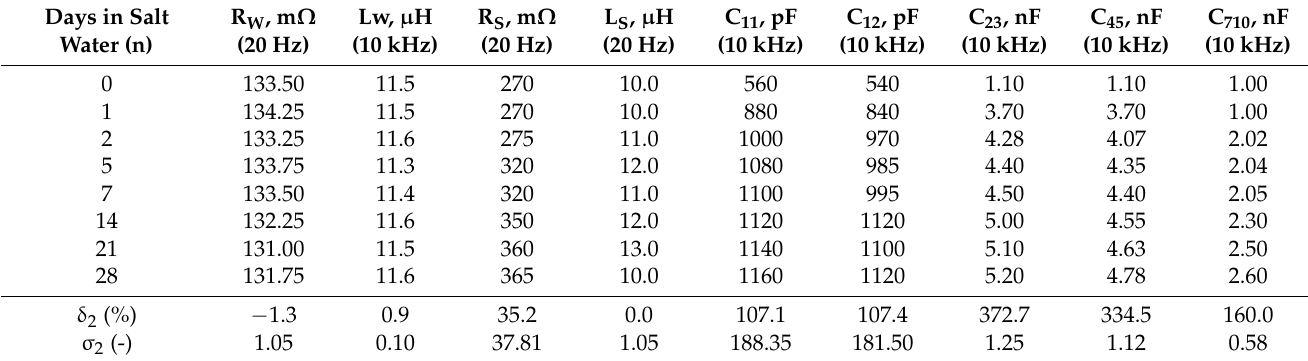
Table 3. Measurement results of CT2 (n = 0 stands for the nominal parameters of the